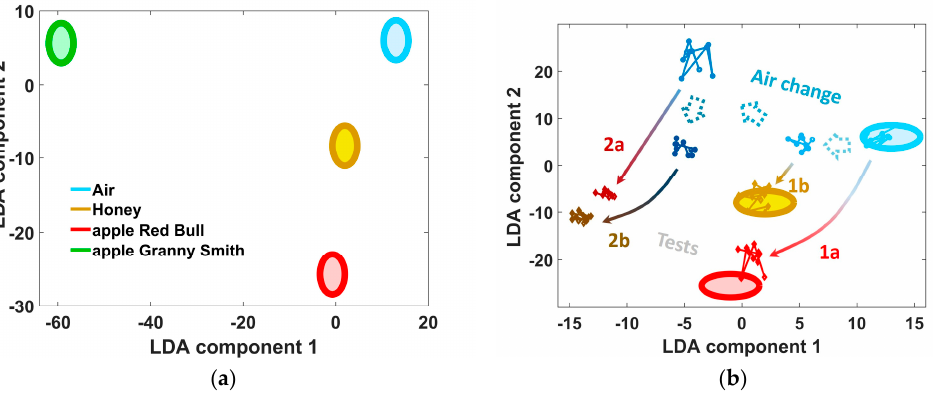
Figure 1. The e-nose data tested at the short-term scale versus elementary LDA model. The ellipses indicate the positions of training class data obtained at elementary model mode. ( a ) The position of analyte-related ellipses in the LDA elementary model; ( b ) two rounds of analyte recognition by the E-nose. “a” and “b” designate the test e-nose data transitions at the exposures to apple of first sort and honey, respectively. The e-nose data measured at round 1 (1a and 1b) have been taken about 15 min after the collection of training sampling and within 15 min one after another. Then, after a pause of 40 min, the e-nose data have been collected at round 2 (2a and 2b).